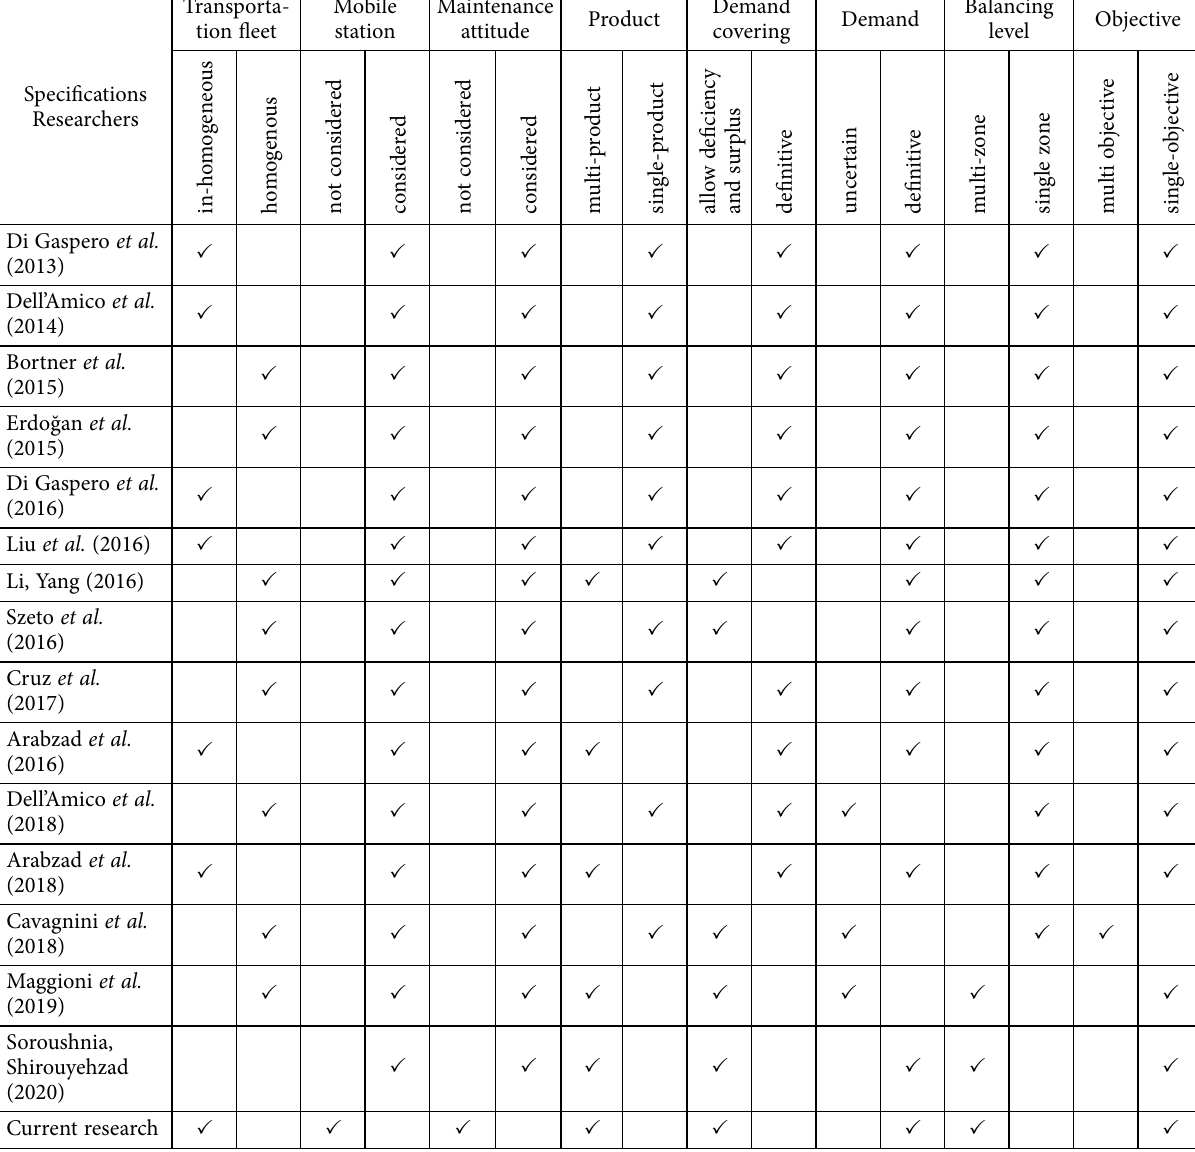
Table 1. A review of the most important researches in the field of BSS